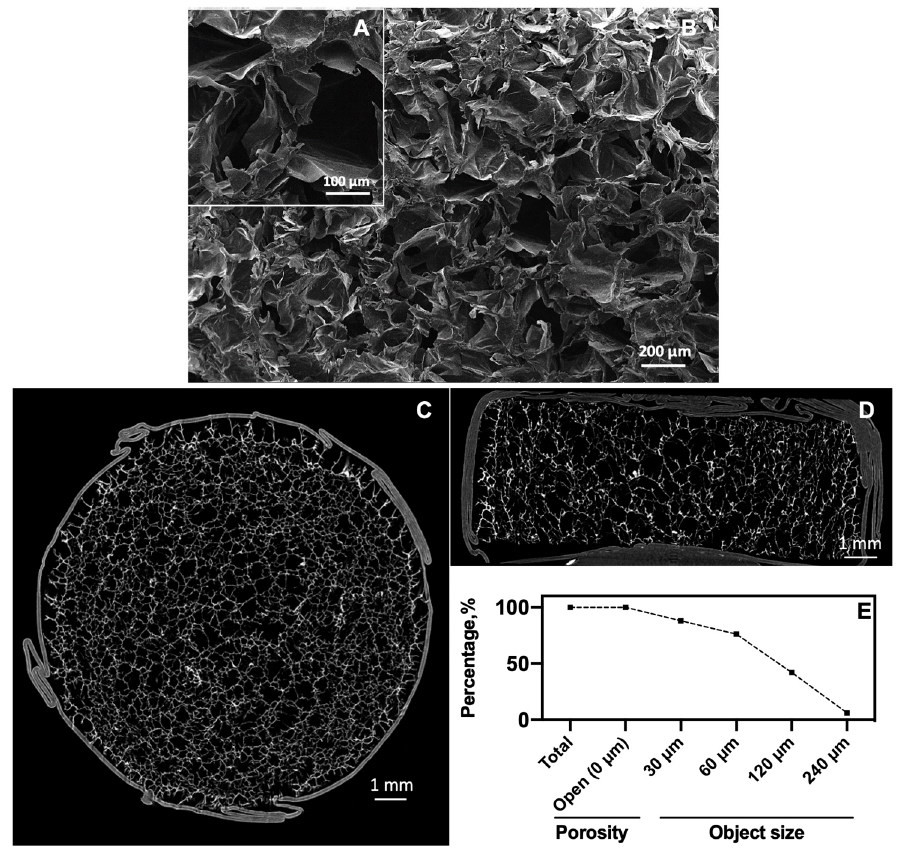
Figure 2. Analysis of the microstructure of the CHT/PCD sponge. SEM images of the cross-section of the scaffold: ( A ) At ×50 and ( B ) at ×100 magnification. μ CT cross-section images: ( C ) Horizontal view, ( D ) vertical view (both images show the parafilm layer used around the samples), and ( E ) percentage of available interconnected porosity to allow passage of an object of defined size into the scaffold.